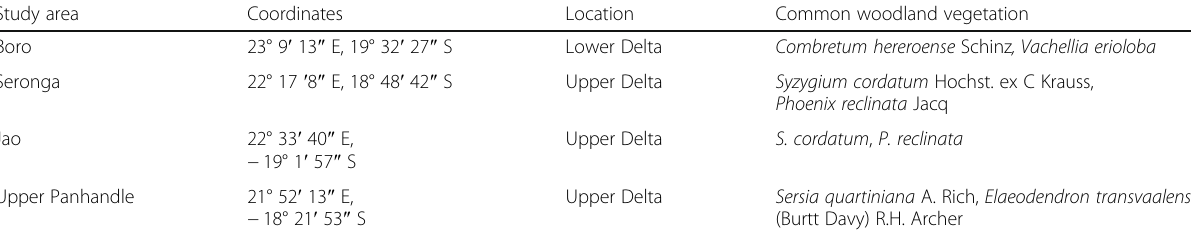
Table 1 Characterization of different sampling sites in the Okavango